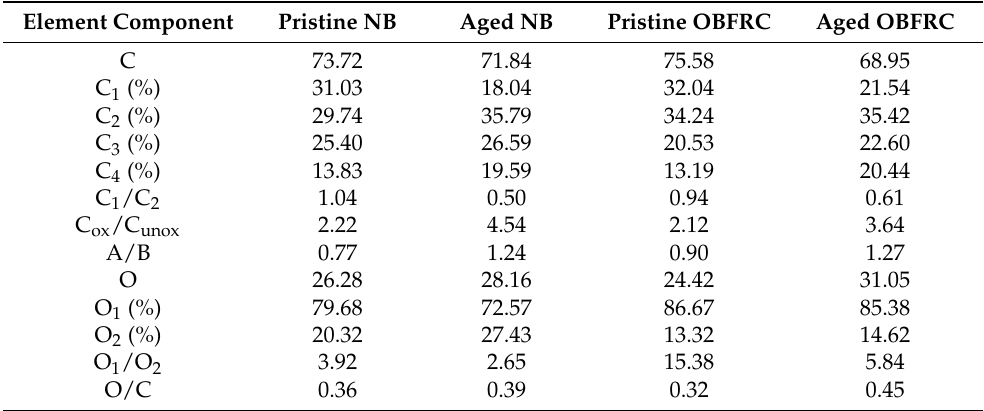
Table 4. Summary of XPS spectral parameters of NB and OBFRC before and after irradiation for 200